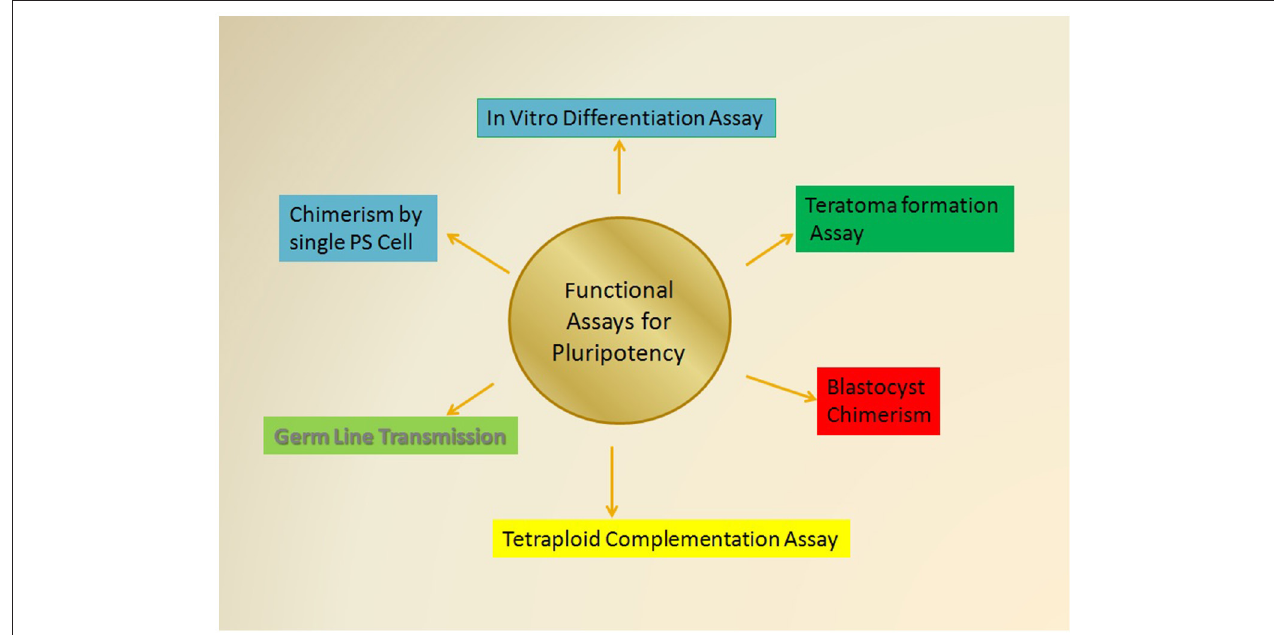
FIGURE 3 | The Various functional assessment approaches for Pluripotency. The most stringent tests for the determination of pluripotent cells that includes the various functional assay that essentially rely on the capabilities of test pluripotent cell to self-renew and differentiate into all the three germ cell lineages including ectoderm, mesoderm, and endoderm as mentioned in the text. Some of these assays would also explore the ability of test cells to give rise the whole organism and give rise to a chimeric animal of desired